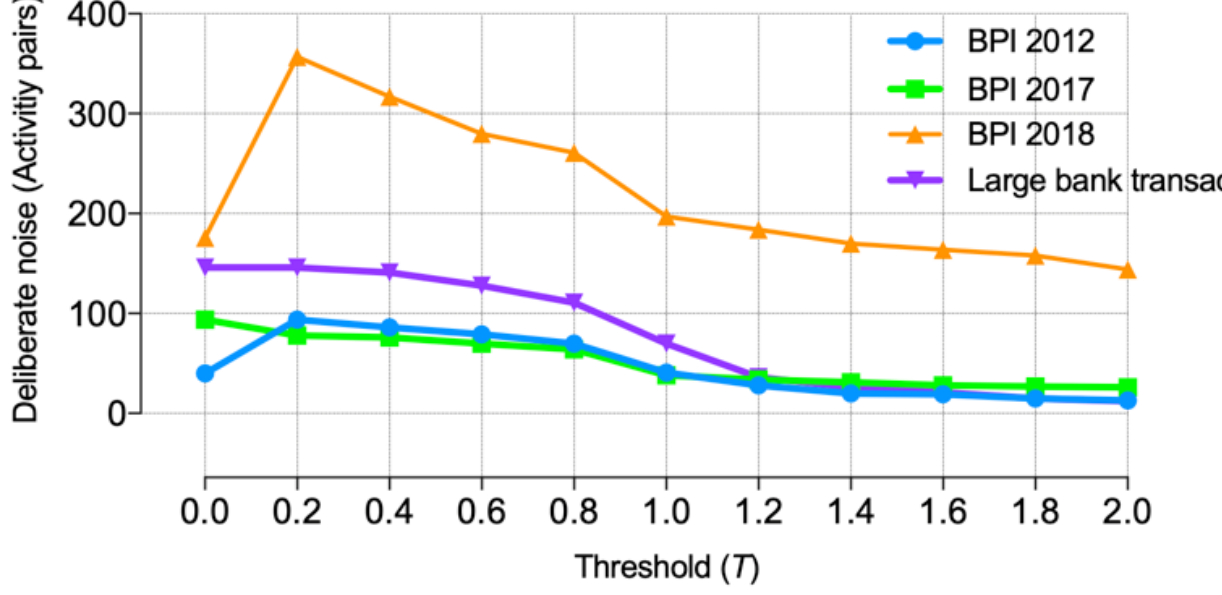
Figure 5. The numbers of temporal activity-sequencing noises in the datasets of the experimen- tal